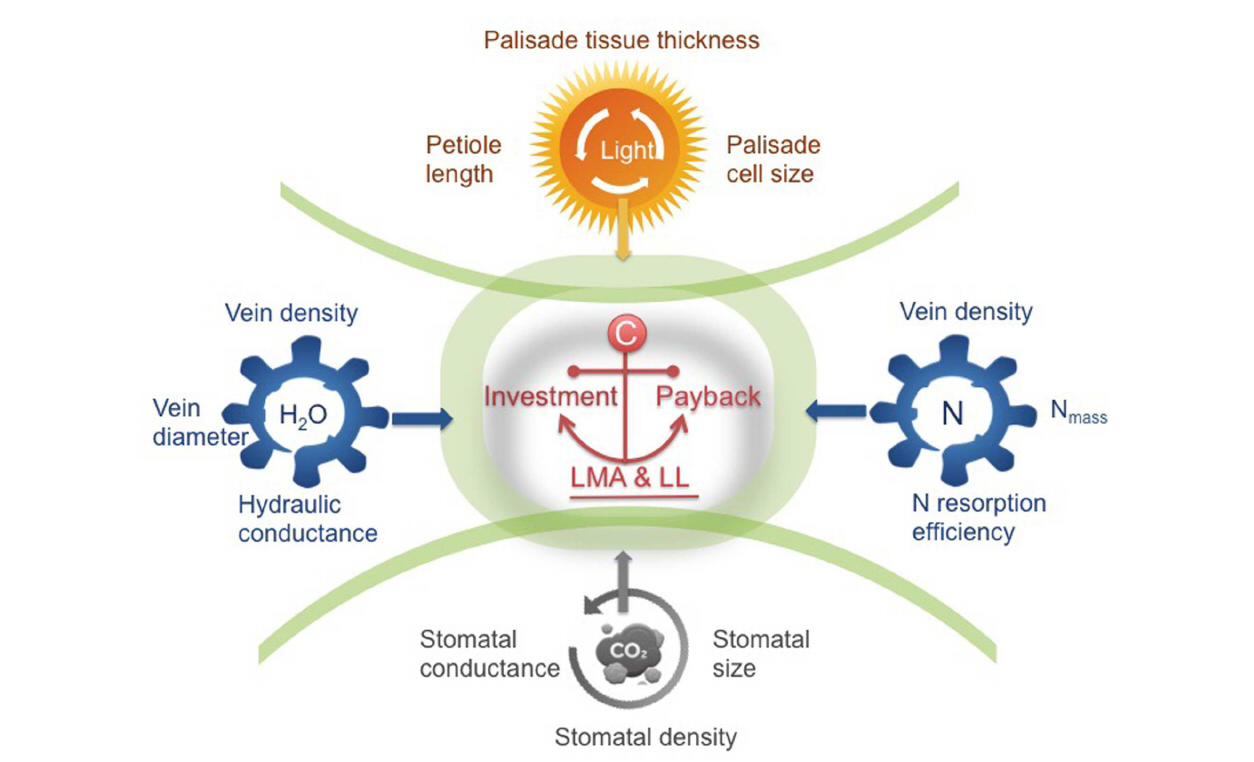
FIGURE 2 | A trait framework based on the three key sub-leaf modules. In the center, the leaf economics spectrum (LES) concept of integrating investment and payback (LMA and leaf longevity, LL) is a fundamental principle, defining the trade-offs of the three modules. By unpacking the trade-off between LMA-LL into four other relations (i.e., interactions between leaves and light-water-nutrients-gas composition), we show the pathway moving beyond traditional leaf economics. Taking this framework as a starting point, we can have a more holistic understanding of global-scale variation in leaf structure and function. Certain trait syndromes are suggested for each module, ranging from cell size, tissue-level density or thickness to the rates of physiological